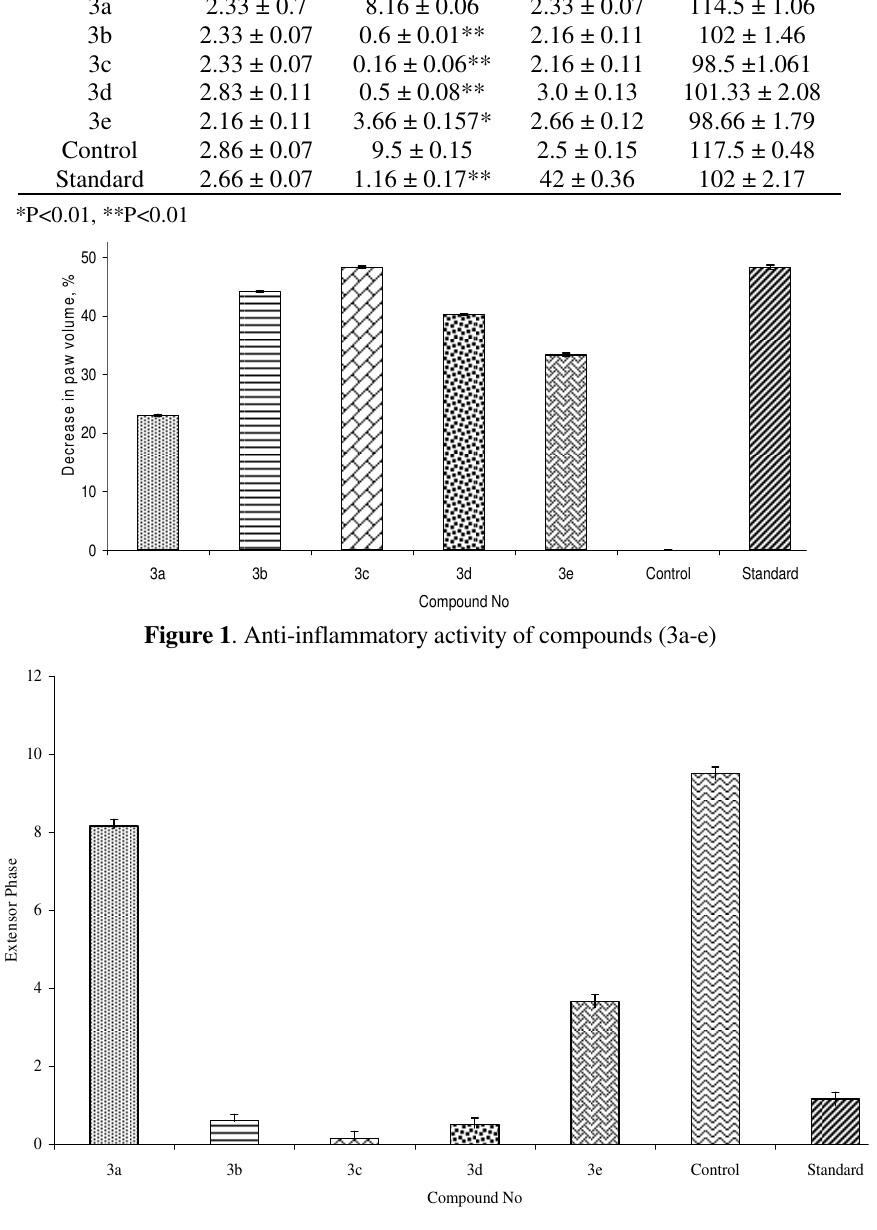
Figure 2 . Anticonvulsant activity of compounds